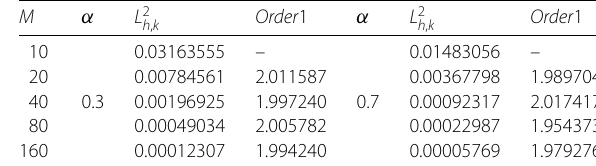
Table 2 The space-convergent orders and errors of PASE-I scheme solution ( N = 1000)